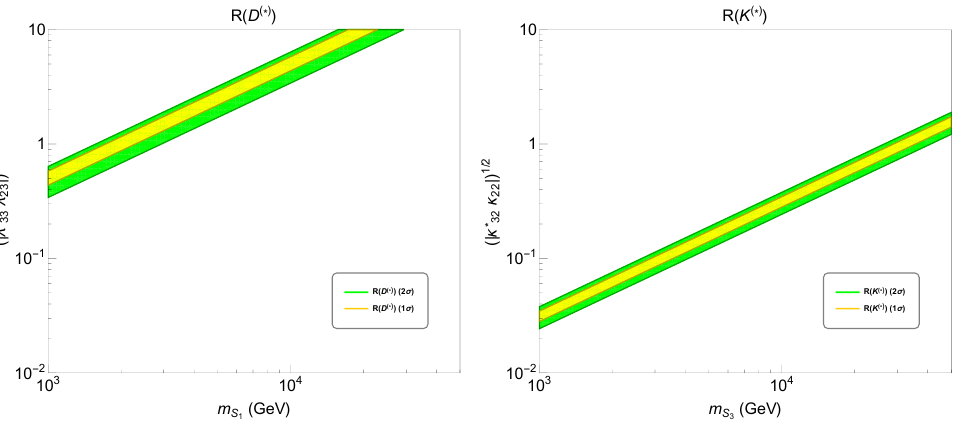
Figure 1 . Parameter space for the leptoquark mass m LQ and the e(cid:11)ective coupling (cid:21) e(cid:11) , explaining the B-meson anomalies, in green(yellow) region at 2 (cid:27) (1 (cid:27) ) level. We have taken m LQ = m S p (cid:21) e(cid:11) = j (cid:21) (cid:3) (cid:21) 23 j for R on left plot, and m LQ = m S D ( (cid:3) ) 33 right plot.